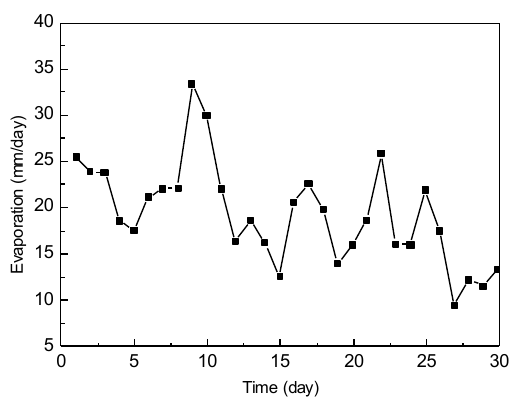
Figure 7a. Variation of the evaporation at the soil surface (Case study)